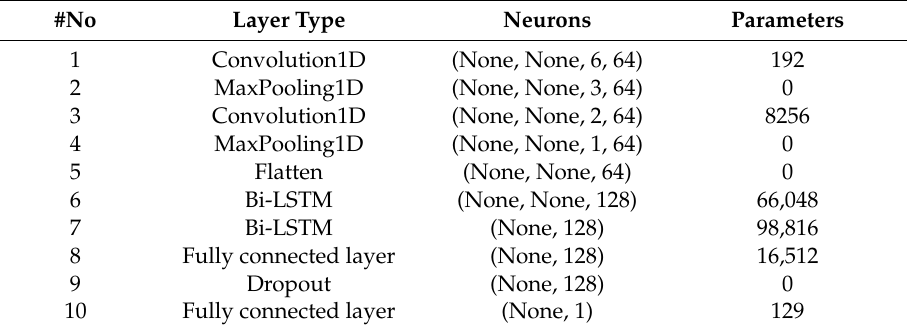
Table 2. The structure and configuration details of the proposed